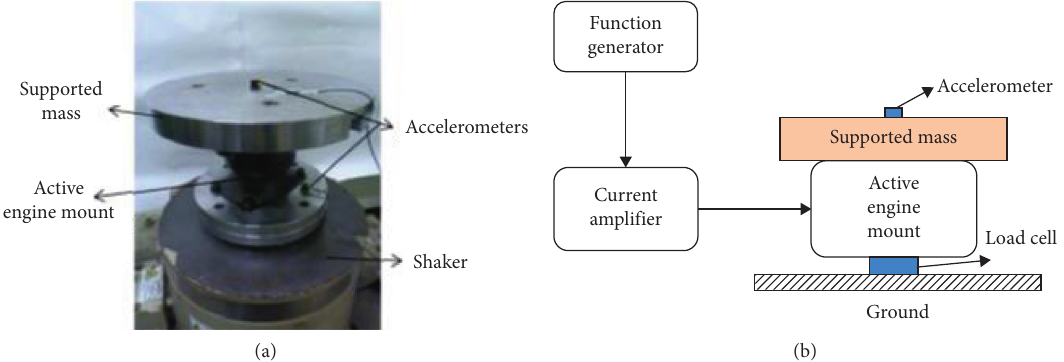
Figure 9: Identification of the AEM [135]: (a) passive component of AEM identification; (b) active component of AEM identification.